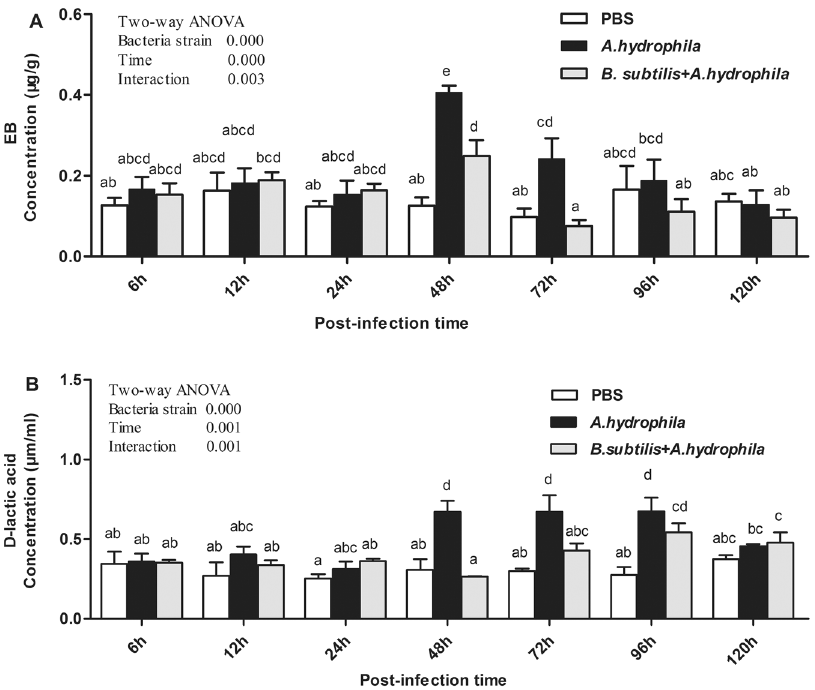
Figure 1. Effect of A. hydrophila on the concentration of intestinal EB and serum D-lactic acid after oral intubation with B. subtilis . Results shown are Mean ± SD (n = 6). EB: Evans